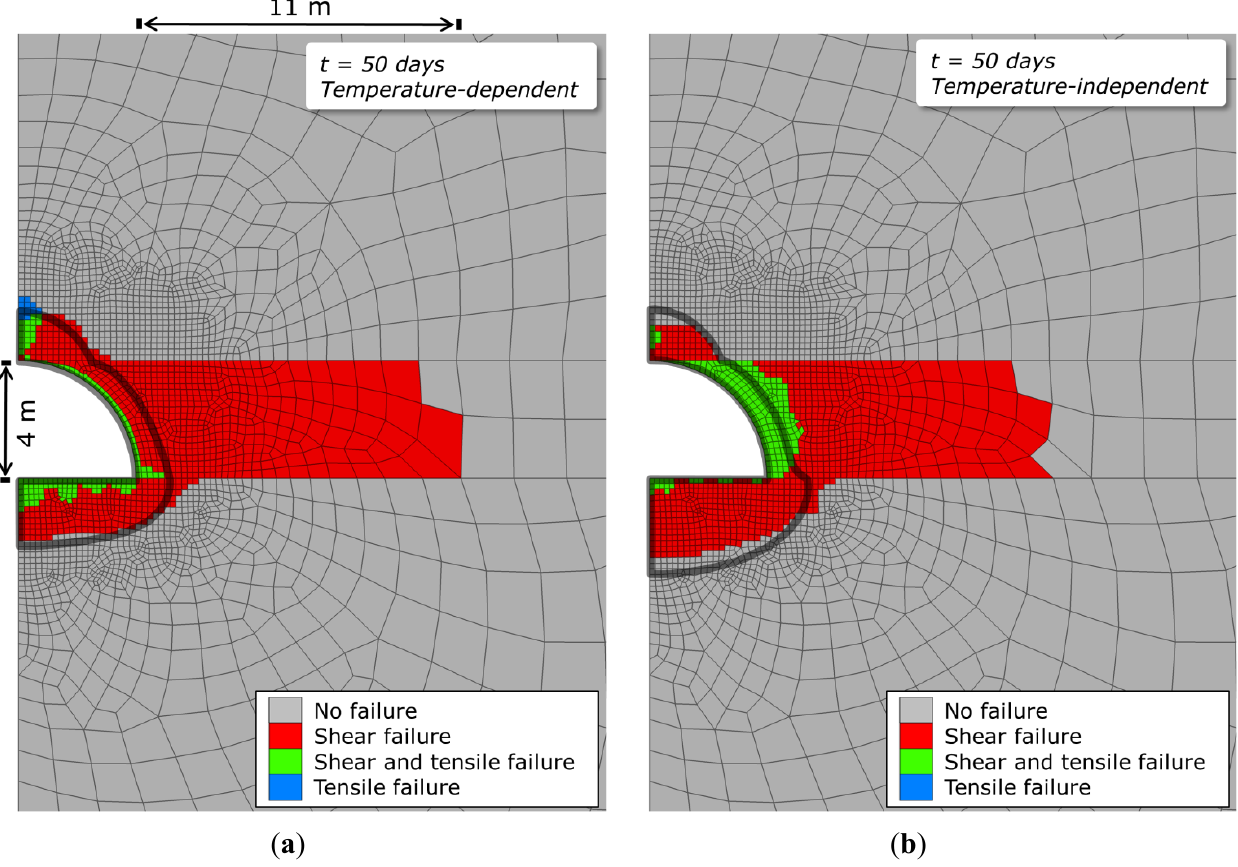
Figure 11. Distribution of shear and tensile rock failure experienced by rocks surrounding the UCG reactor after stepwise reactor zone excavation with ( a ) temperature-dependent and ( b ) -independent properties after 50 days of simulation. The grey solid line represents the 200 °C